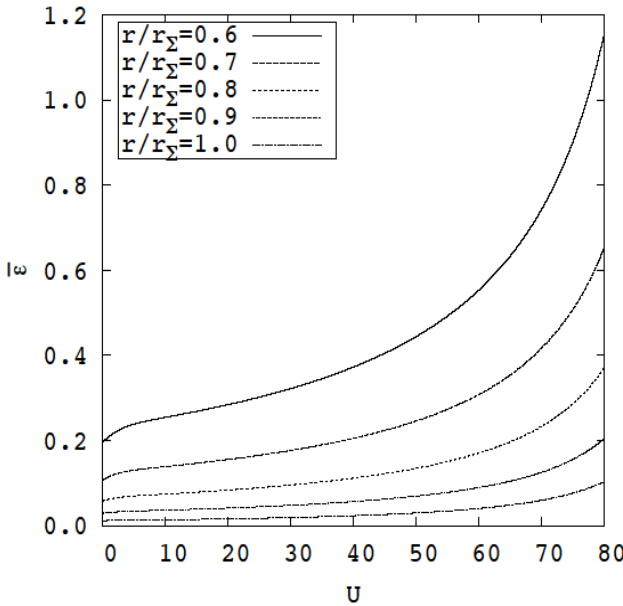
Figure 6. Radiation flux (multiplied by 10 2 ).